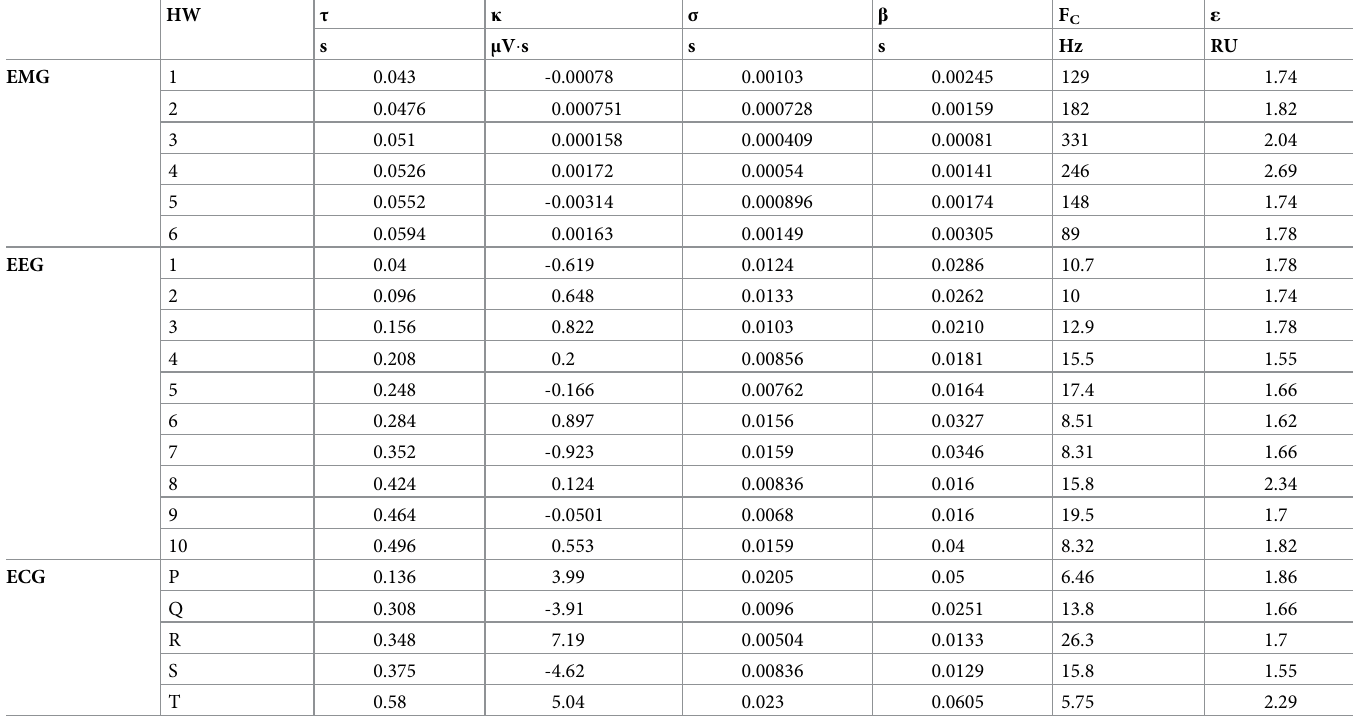
Table 1. Parameters of half-wave